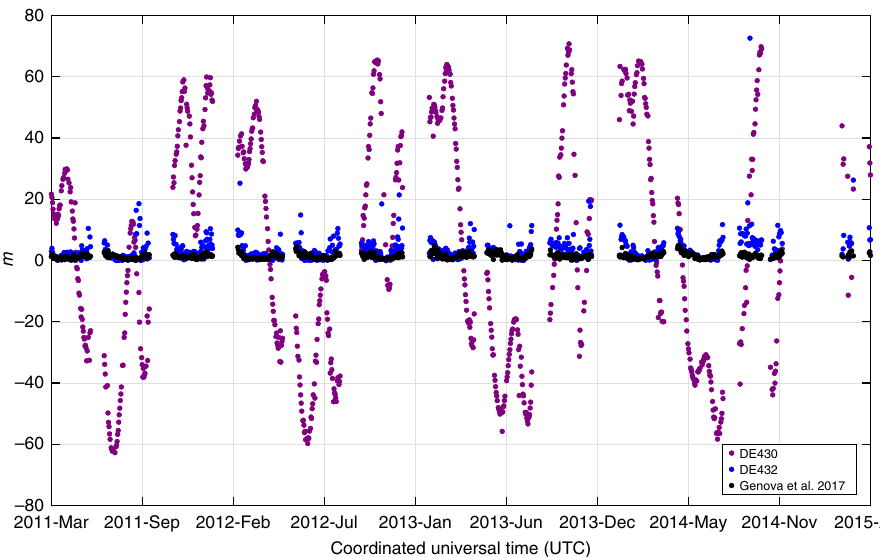
Fig. 3 Temporal distribution of the range biases with three Mercury ’ s ephemeris. The measurement biases are required to fi t the MESSENGER range data at the noise level with the JPL DE430 (purple) and D432 (blue) ephemerides, and our integrated trajectory for Mercury (black). These biases were used to determine the quality of the ephemeris results. After convergence of the global solution, all the adjusted parameters (Methods) are applied in a fi nal iteration, in which the range biases are adjusted instead of the Mercury ’ s initial state, GM (cid:1) , J 2 (cid:1) , β , η , and _ GM (cid:1) = GM (cid:1) . Large range biases suggest signi fi cant errors in the planet ’ s